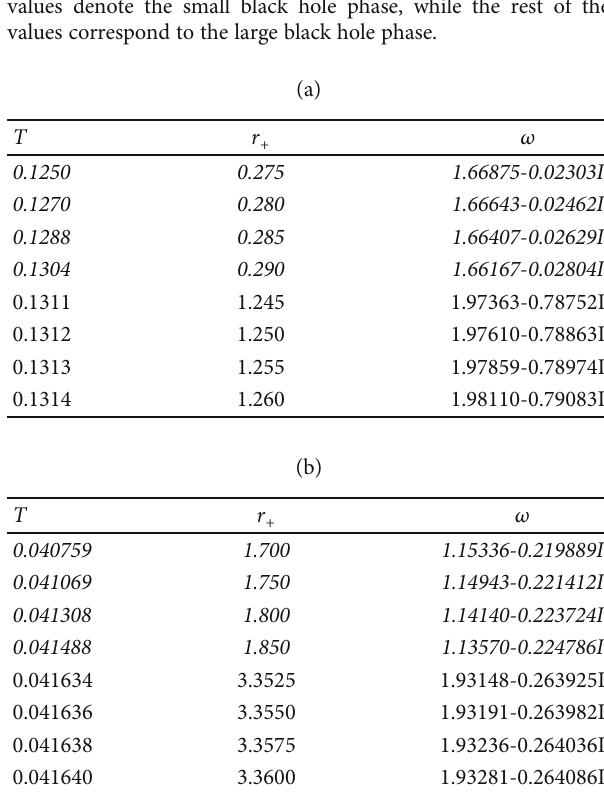
= − 1 , ω = 1/3 , and P = 0 : 0328 . s s = − 2/3 ) and (b) ( ω = 1/3 ) s s